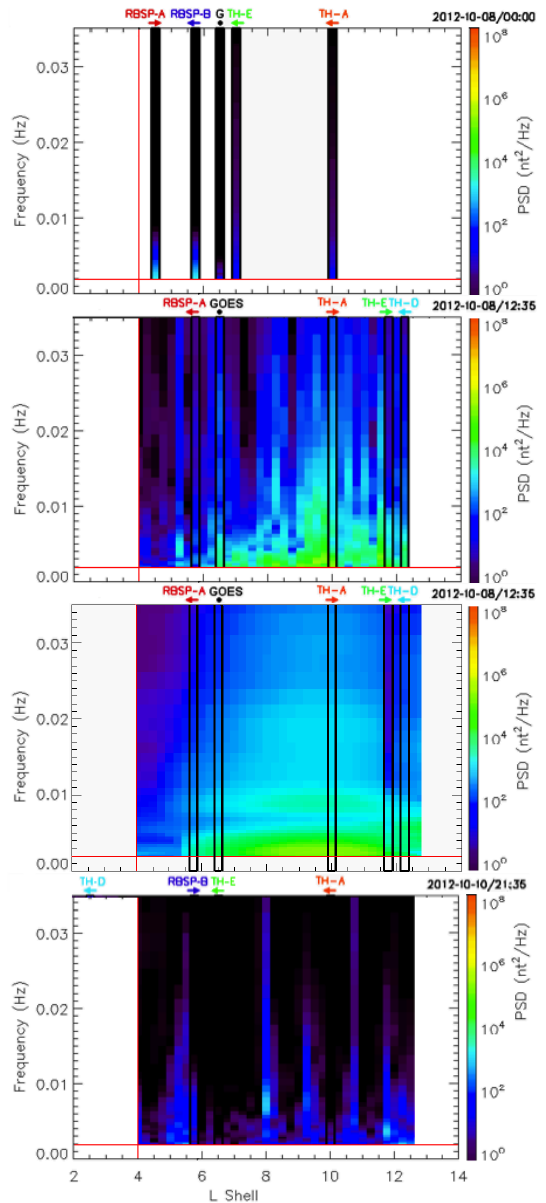
Figure 2. (a) Power Spectral Density is shown in color in a frequency-vs.- L plot, for 8 October 2012, 00:00UT, at the six lo- cations of the spacecraft whose magnetic field measurements are used in this study; spacecraft names are written on the top of the panel, and arrows under the names indicate the spacecraft direction of motion (inbound or outbound). (b) Similar to the top panel, for 12:35UT; PSDs outside the locations of the satellite at that time in- dicate the last available measurement (or “memory” of the PSD) at each location. (c) Based on the individual measurements made at the satellite locations in (b) , an interpolation is performed to tie the measurements into a concise picture for the entire magnetosphere. (d) Same as (a) and (b) but for 21:35, during the recovery phase of the